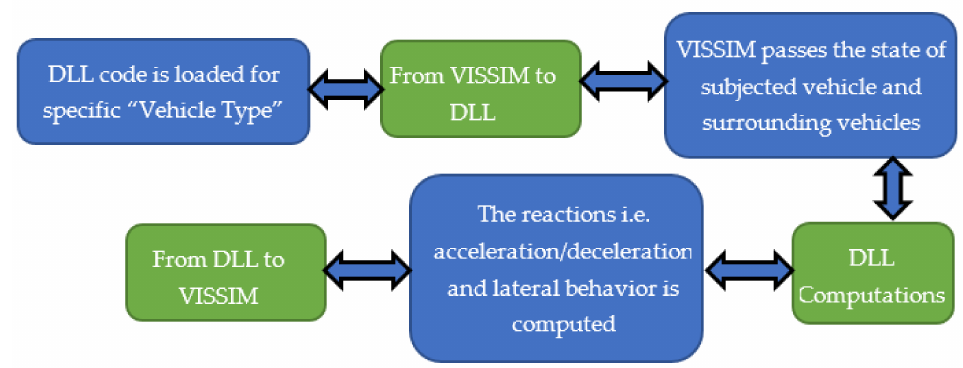
Figure 2. VISSIM and External DriverModel-DLL working